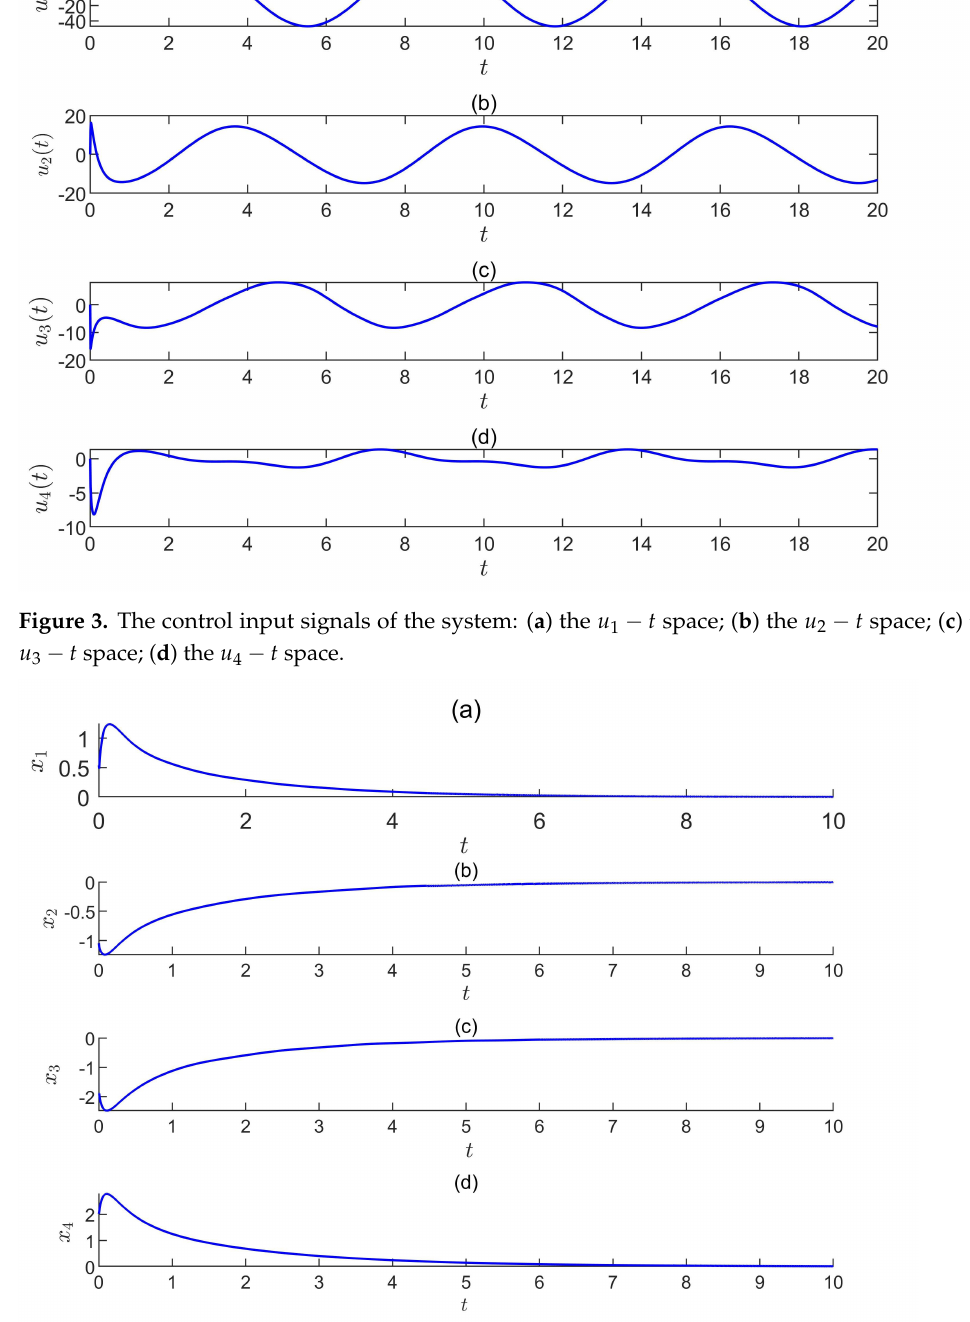
Figure 4. The state trajectories of the system (26) under the controller (31): ( a ) the x 1 − t space; ( b ) the x 2 − t space; ( c ) the x 3 − t space; ( d ) the x 4 − t